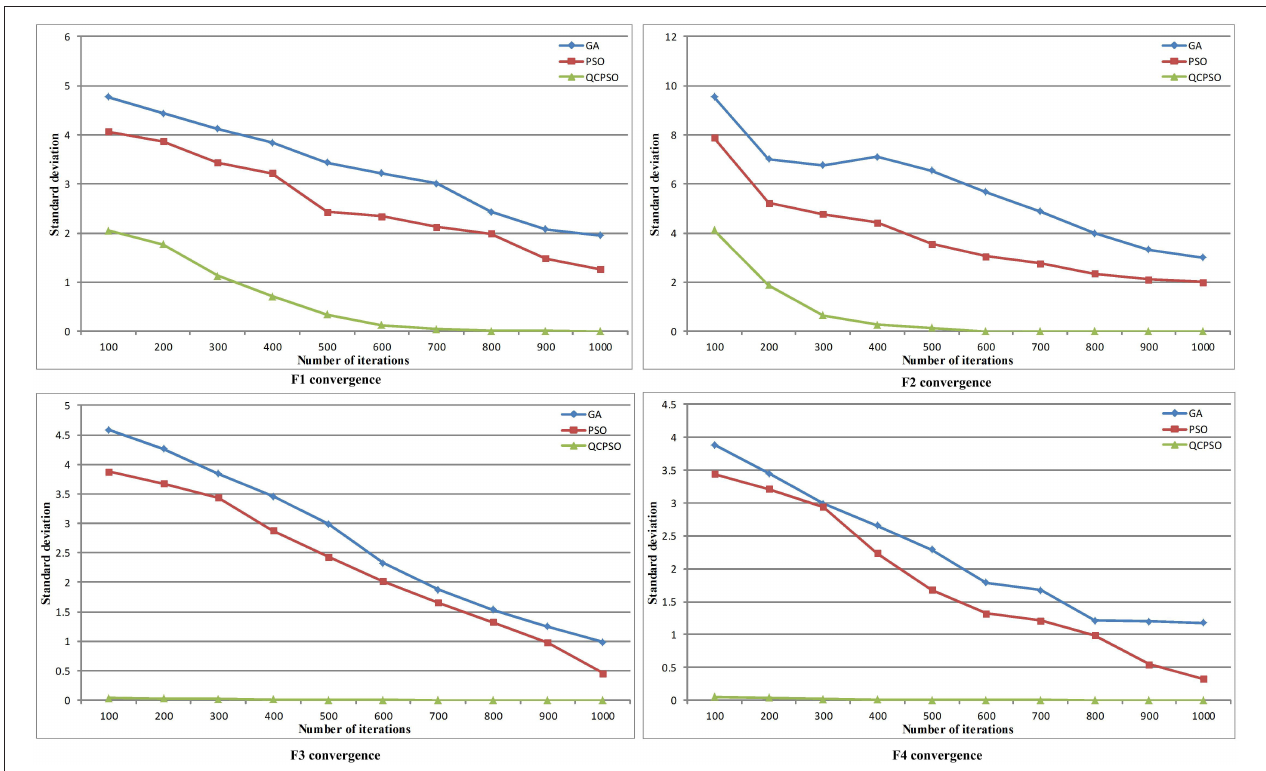
FIGURE 1 | Convergence Comparison of four Functions ( D